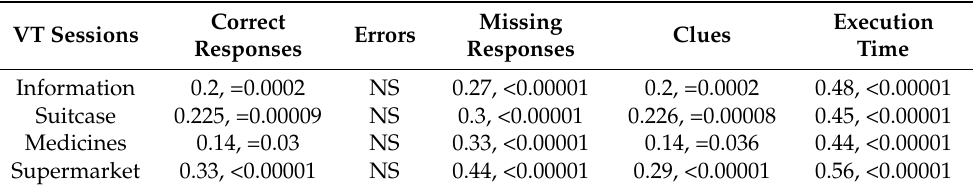
Table 3. Results obtained by the experimental group during the VRT sessions at T2 (Friedman test for repeated